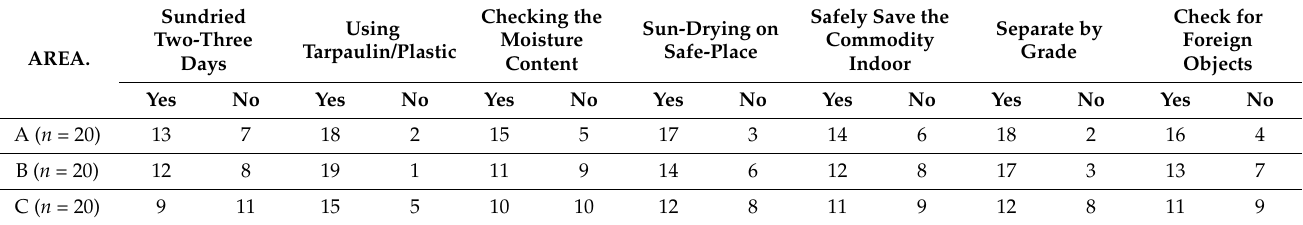
Table 4. The surveyed areas that had implemented the book of requirements guidelines.